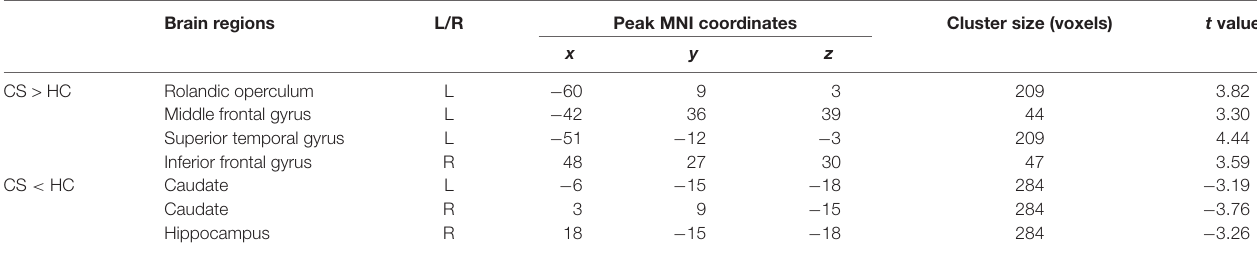
TABLE 2 | Group differences in ALFF between CS patients and HCs. Brain